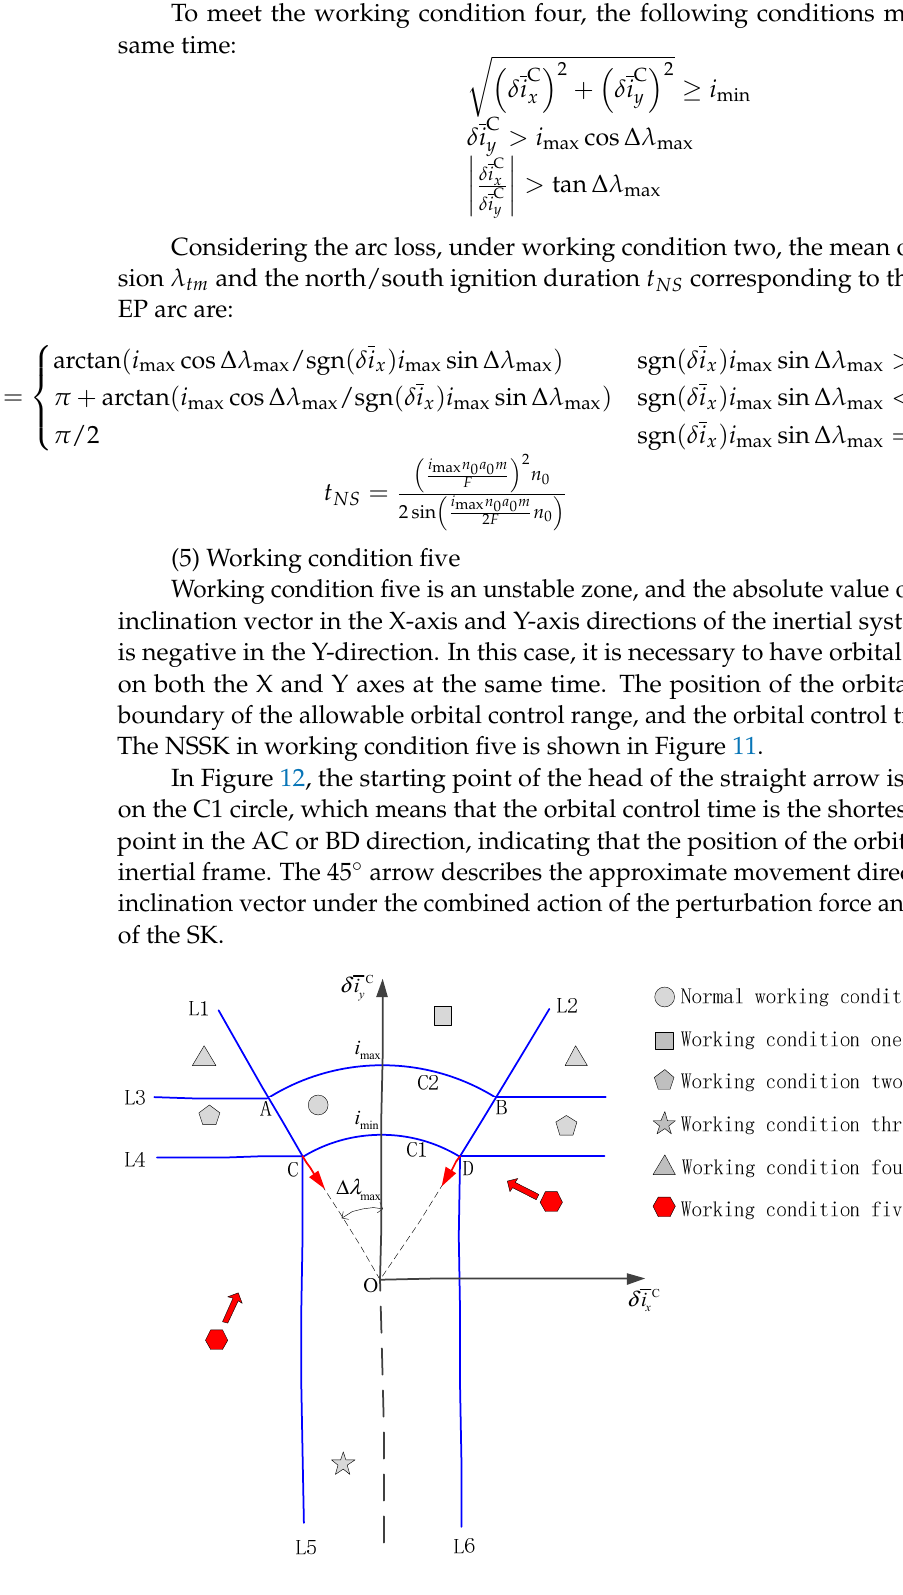
Figure 12. The NSSK in working condition five.